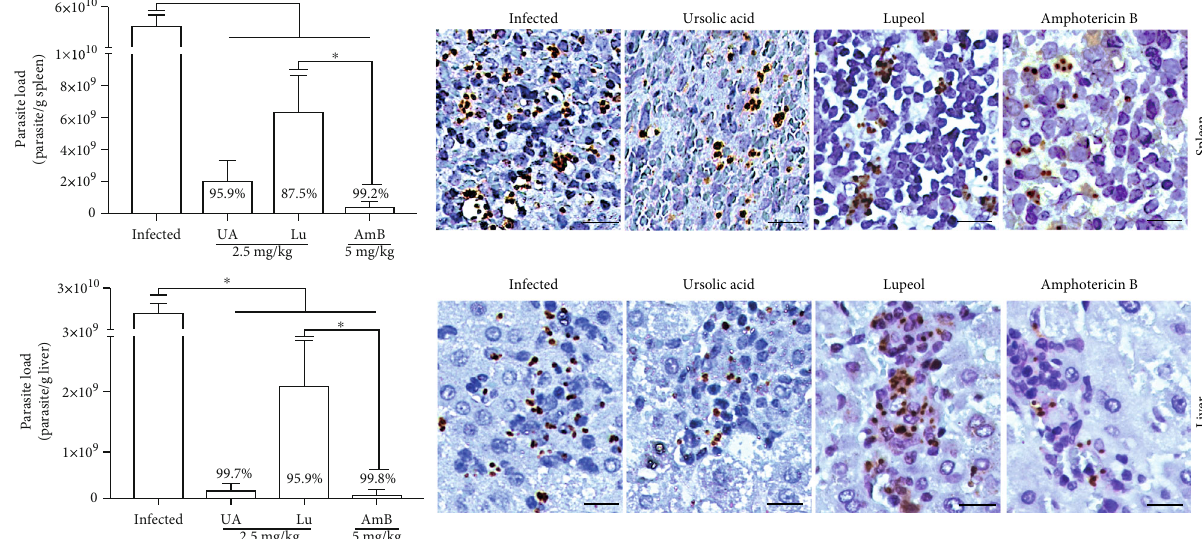
Figure 8: Splenic and hepatic parasitism from hamsters infected with L. ( L. ) infantum and treated with triterpenes. Hamsters were infected with promastigote forms of L. ( L. ) infantum , and four weeks after infection, animals were intraperitoneally treated once daily during 10 days with 2.5mg/kg of ursolic acid (UA), lupeol (Lu), or 5mg/kg of amphotericin B (AmB). The splenic and hepatic parasitism was quanti fi ed by limiting-dilution assay; additionally, amastigote forms were stained by immunohistochemistry